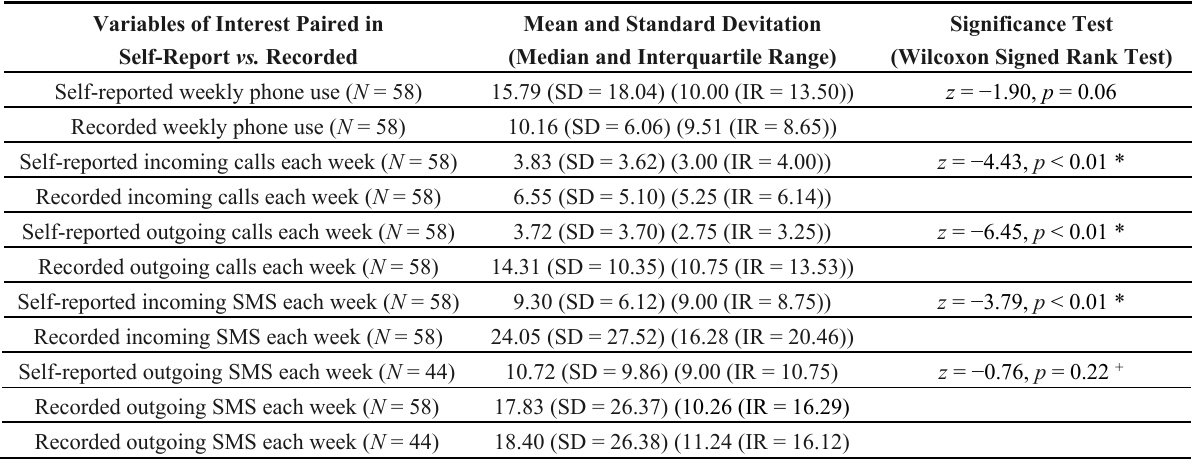
Table 1. Comparison of recorded and self-reported means for phone related